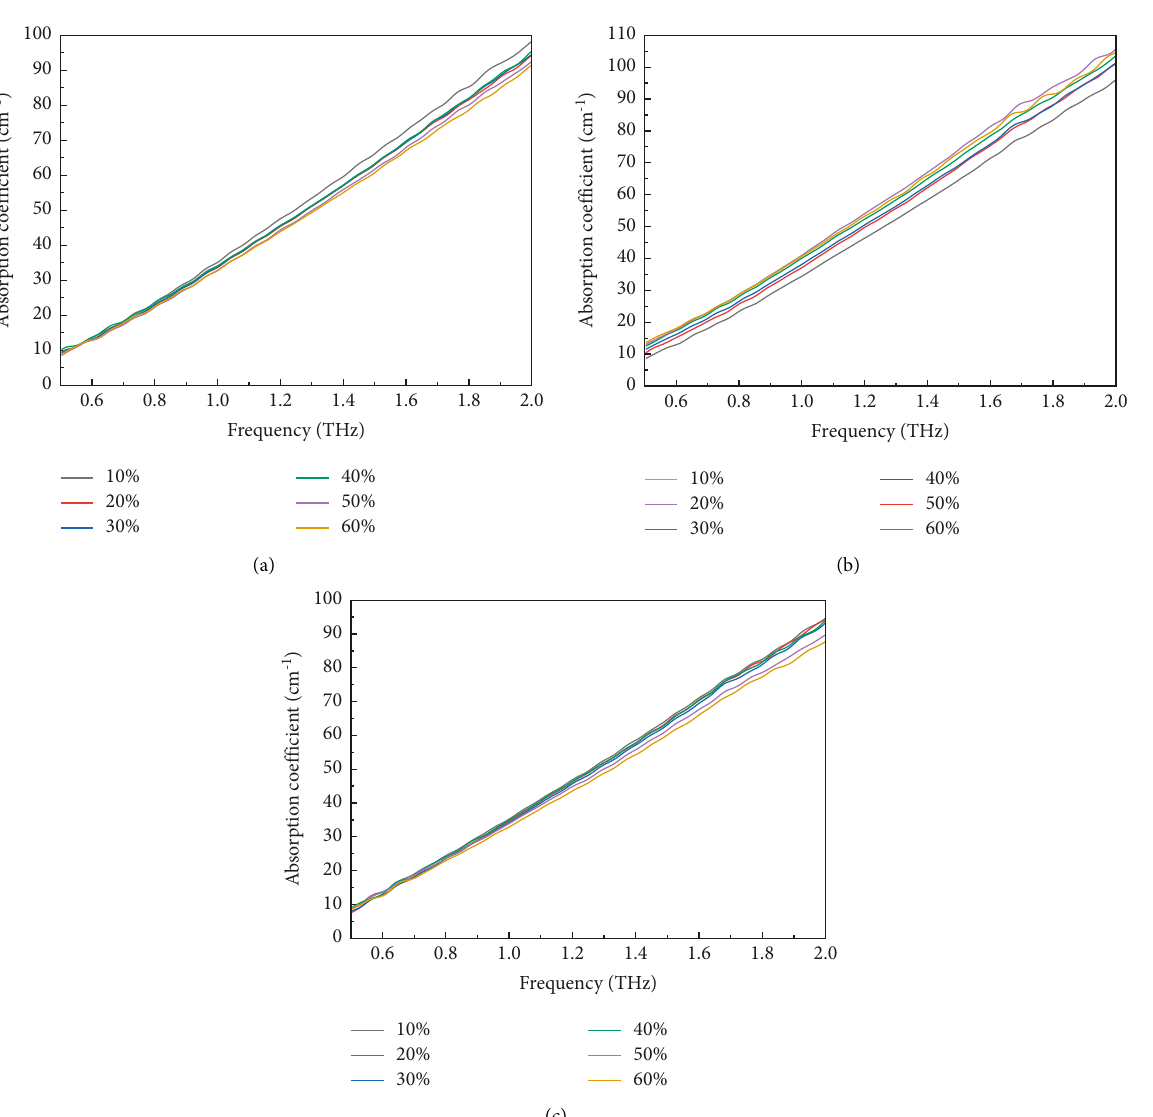
Figure 7: Spectral analysis of absorption coefficient of Panax notoginseng powder with different adulterated concentrations; (a) is adulterating with zedoary turmeric powder; (b) is adulterating with rice flour; (c) is adulterating with wheat